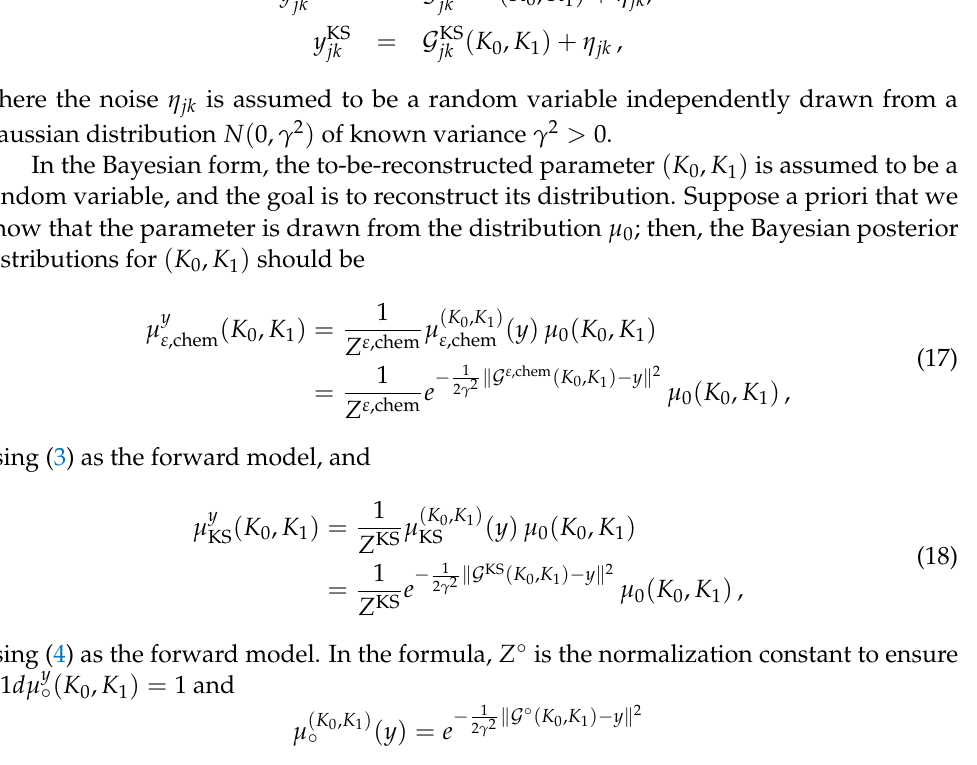
( D , Γ ) from a prior µ KS